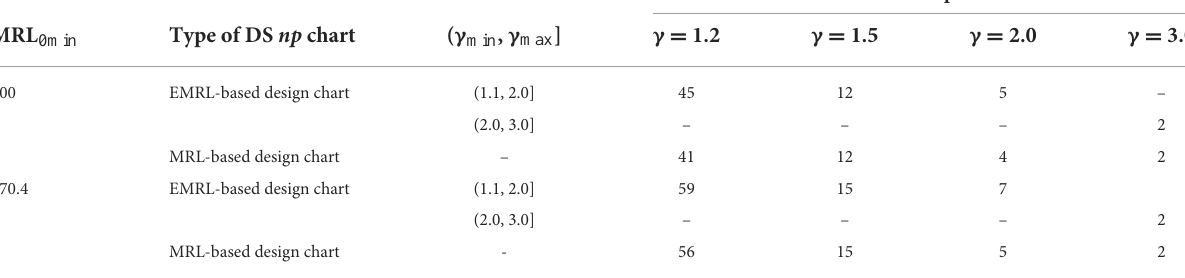
TABLE 5 MRL 1 computed using the optimal charting parameters of the EMRL-based DS np chart and the MRL-based DS np chart for p 0 = 0.01, n = 100, and EMRL 0 ∈ 200,370.4.